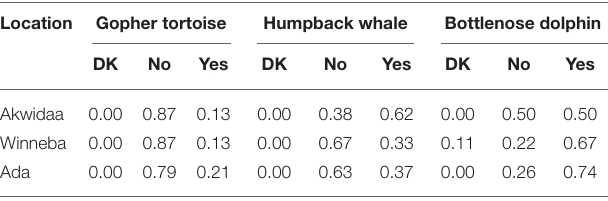
TABLE 4 | Frequency of fishers that reported capturing a tortoise and marine mammals in the artisanal fishery. Location Gopher tortoise